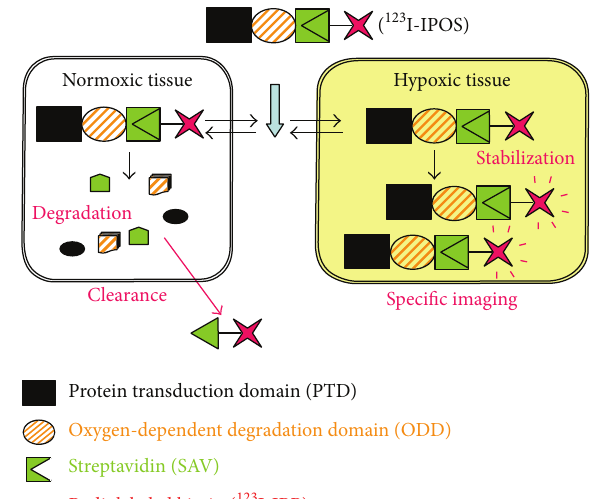
Figure 2: Principle underlying the imaging of HIF-1-active tumor microenvironments, using 123 I -IPOS. The PTD enables 123 I-IPOS to be delivered to all tissues. In normoxic tissues, oxygen-dependent POS degradation occurs and 123 I-IBB loses its binding partner and is cleared. In contrast, in hypoxic tissues, 123 I-IPOS escapes degradation and is retained within cells owing to its molecular size. Thus, 123 I-IPOS allows for specific imaging of HIF-1-active